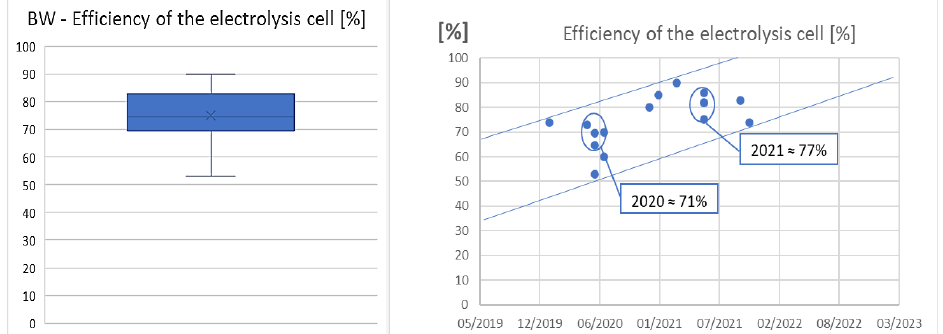
Figure 5. Graphic representation of the efficiency of the electrolysis cell [12,83 – 85,92,93,100,105,108,120,131,138 – 140]. The Faradaic efficiency was mentioned twice 89% [134] and 96.5 % [56].